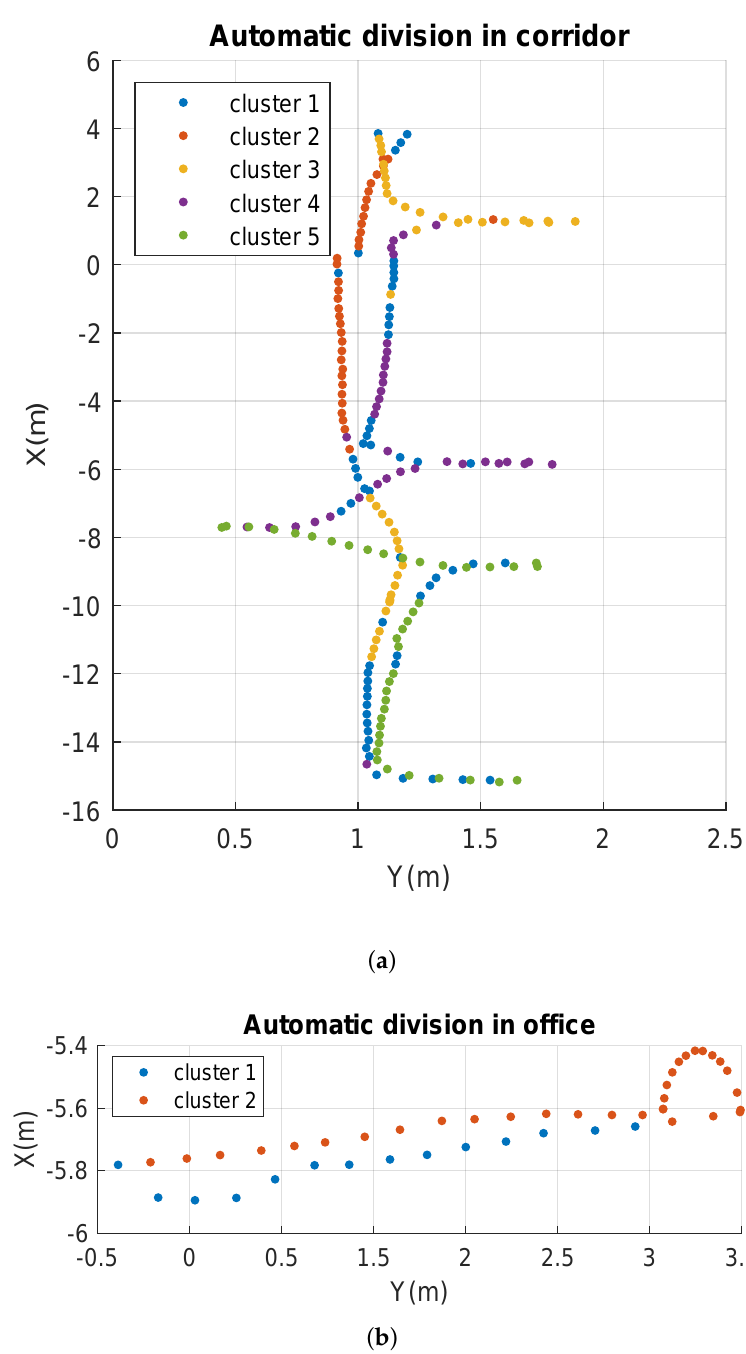
Figure 9. Clusters obtained with spectral clustering for ( a ) corridor with 5 divisions and ( b ) office with 2